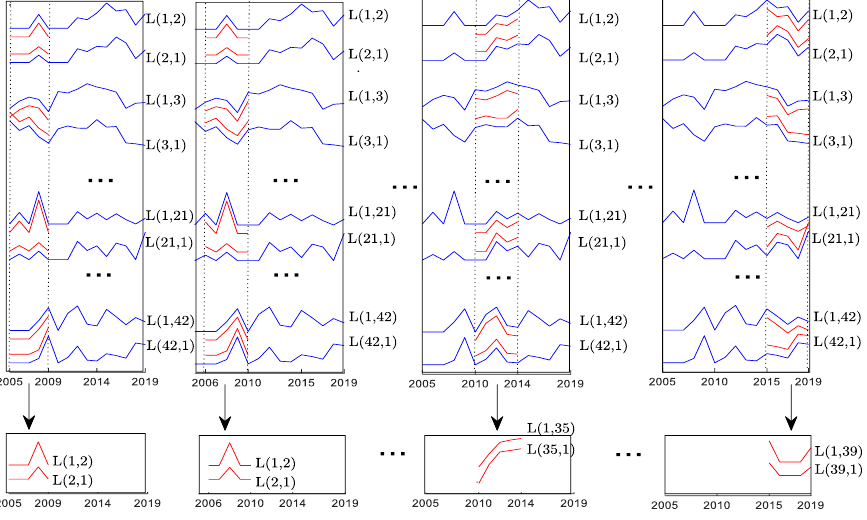
Figure 4. The measurement process for the first topic relative to all other